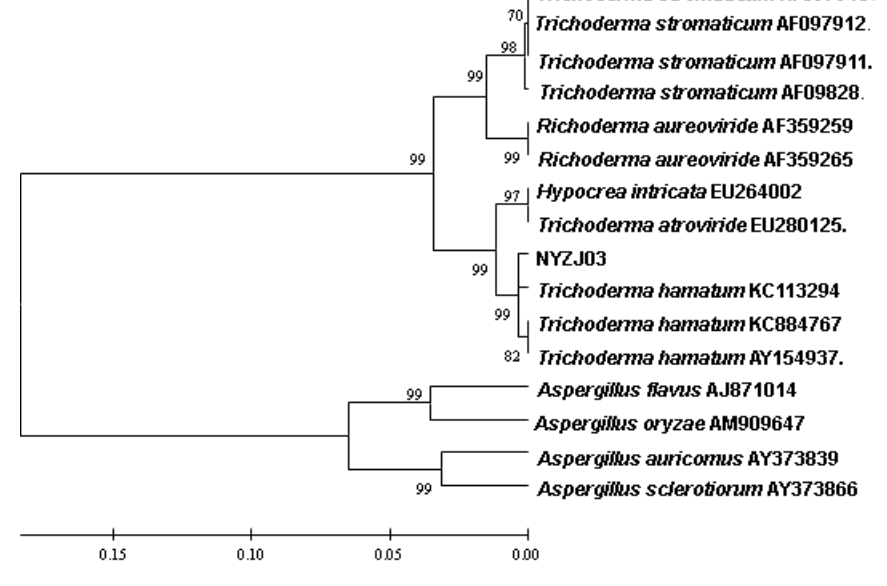
Figure 1. Phylogenetic tree of obtained fungal